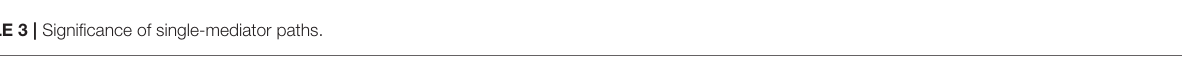
TABLE 3 | Significance of single-mediator